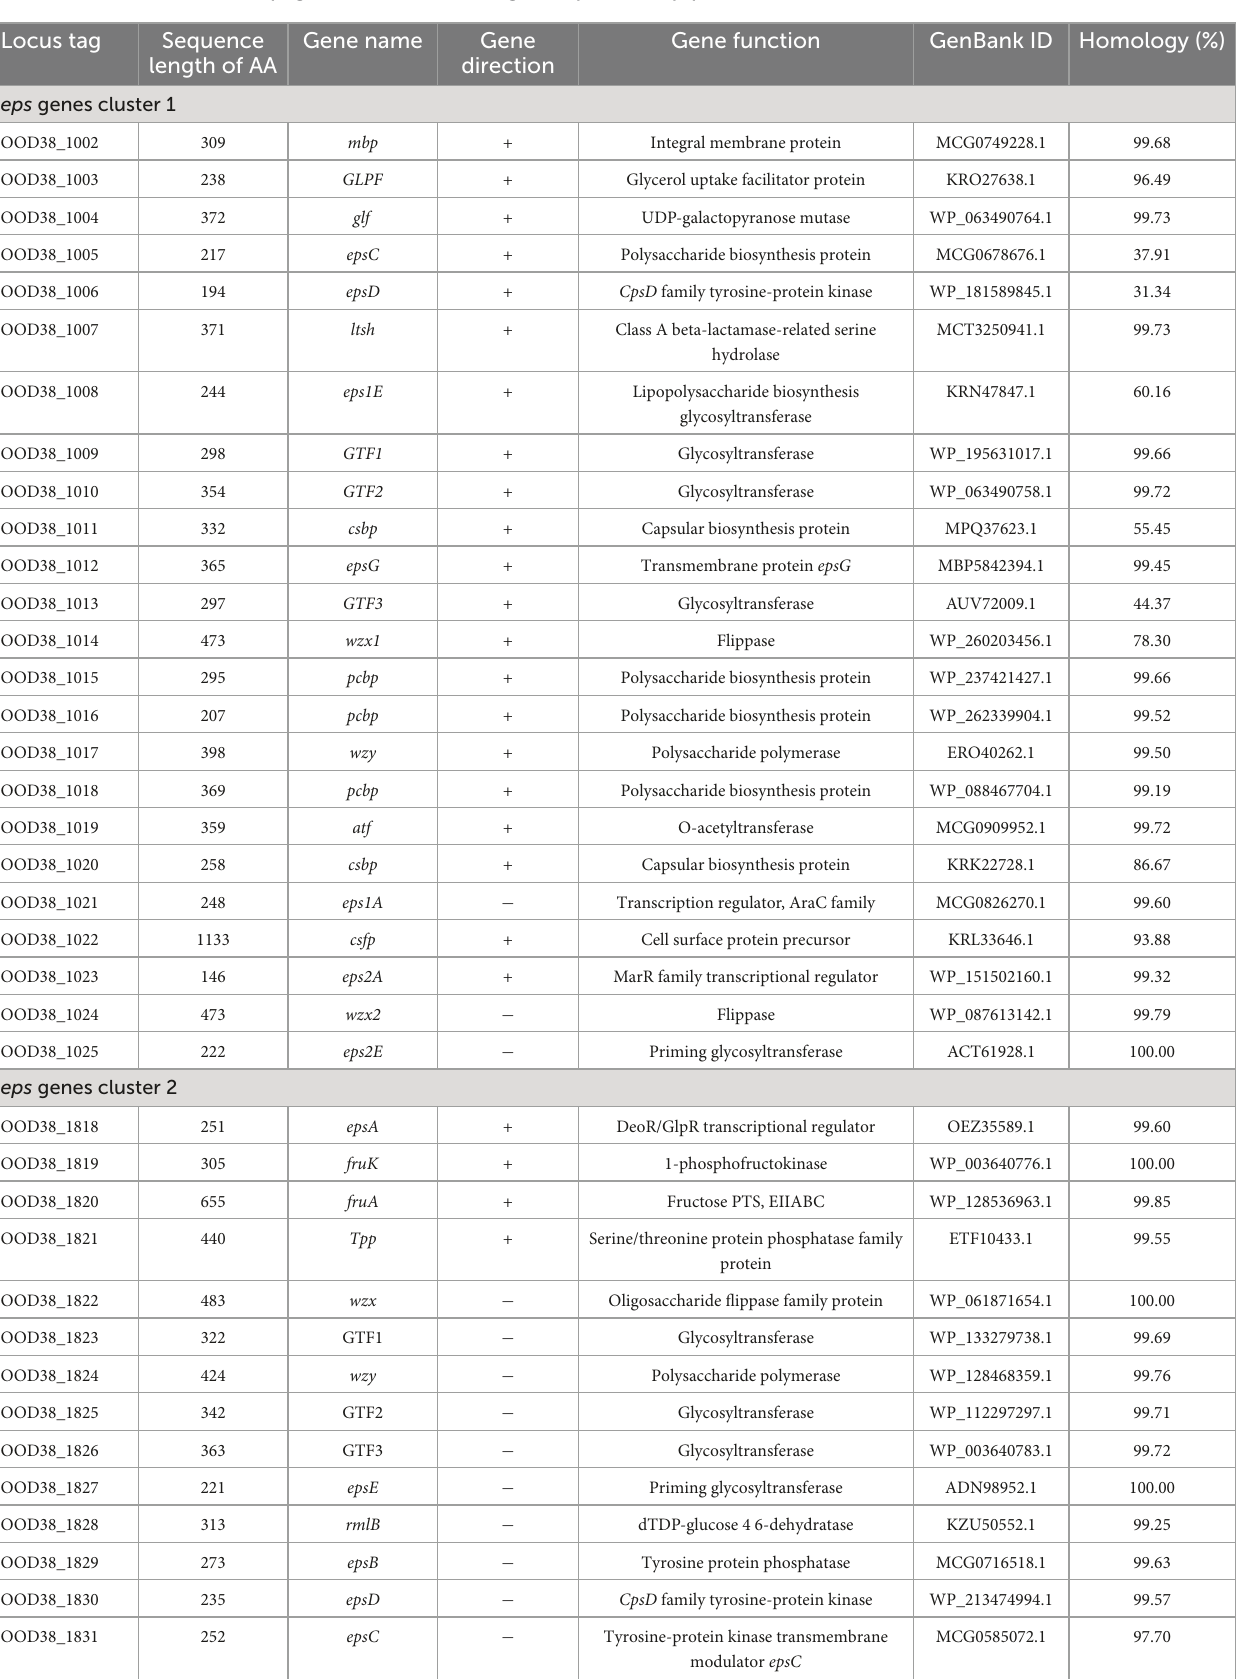
TABLE 4 Information about the eps gene clusters and homologous sequences of Lp. plantarum MC5. Locus tag Sequence Gene name Gene Gene function GenBank ID Homology length of AA direction